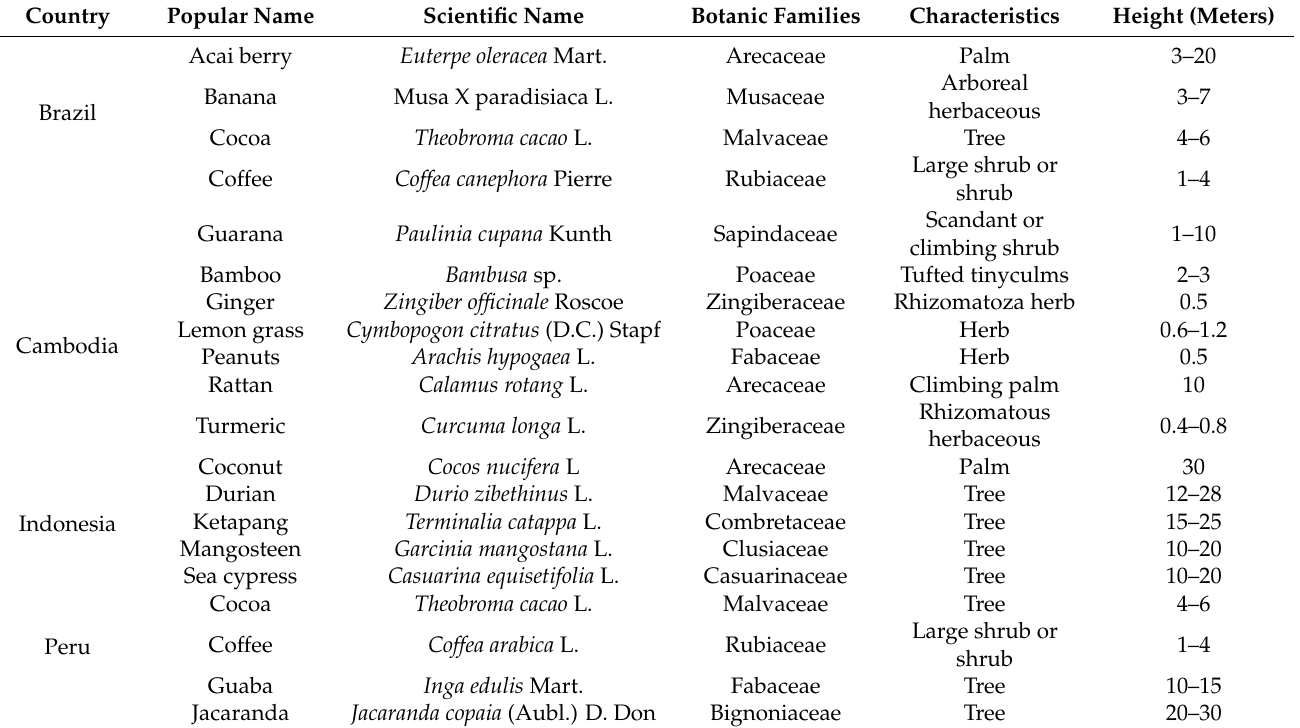
Table 2. Information relevant plant species in forest restoration initiatives surveyed in four rainforest countries in 2018 and